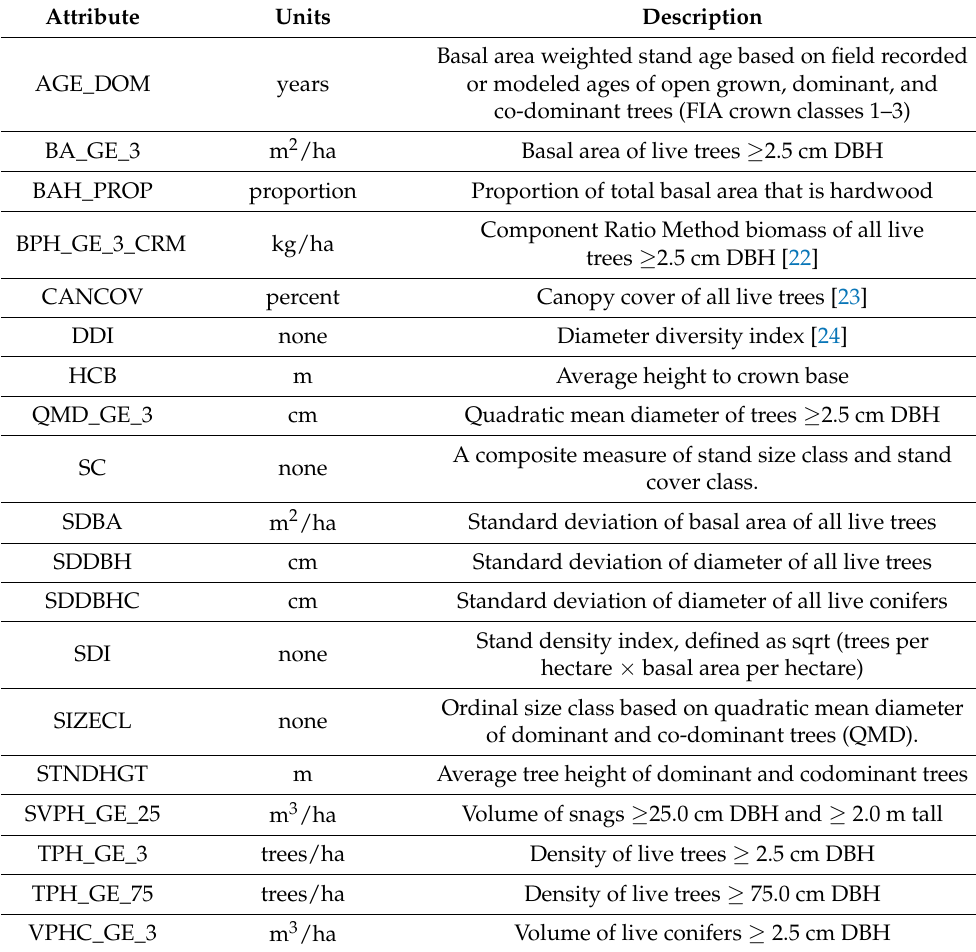
Table 1. Inventory plot attributes for accuracy assessment. Plot attributes were compiled from tree-level records and summarized to plot level (DBH = diameter at breast height).